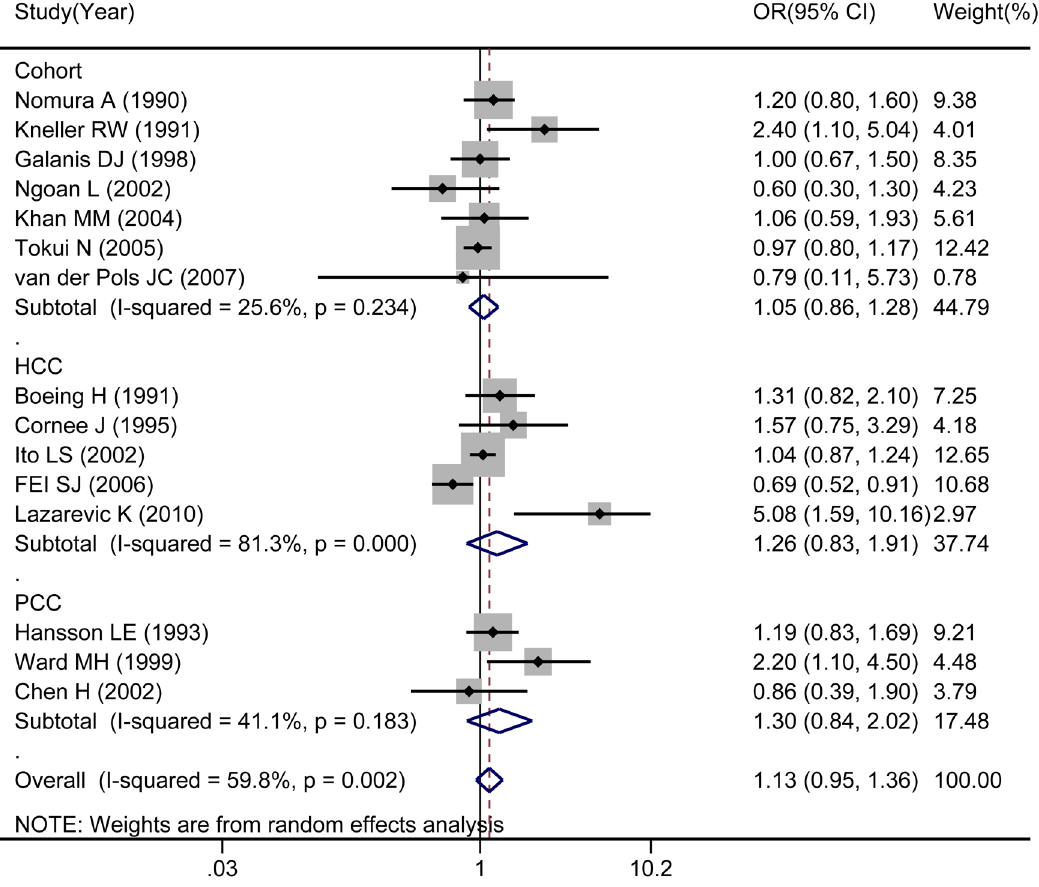
Figure 4. Consumption of milk in association with gastric cancer.